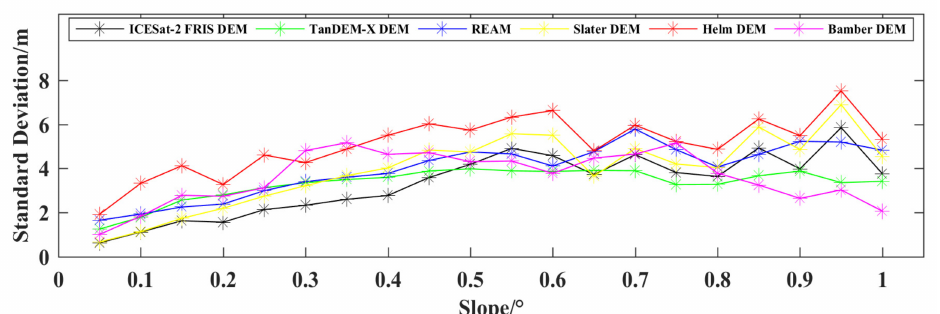
Figure 14. Standard deviations between ICESat-2 FRIS DEM as well as the five Antarctic DEMs and OIB elevations. The horizontal coordinate is the slope of the surface from 0 ◦ to 1 ◦ with an interval of 0.05 ◦ .